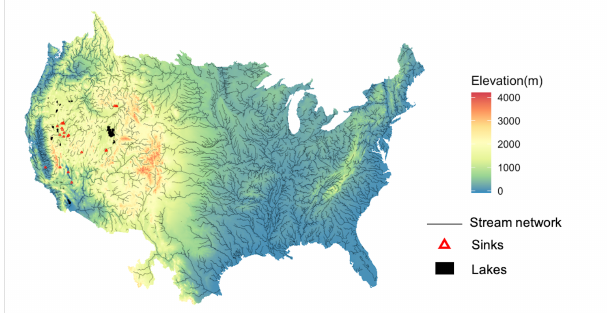
Figure 1. Map of the DEM dataset, stream network, lakes and sinks used for processing the 1km hydrographic